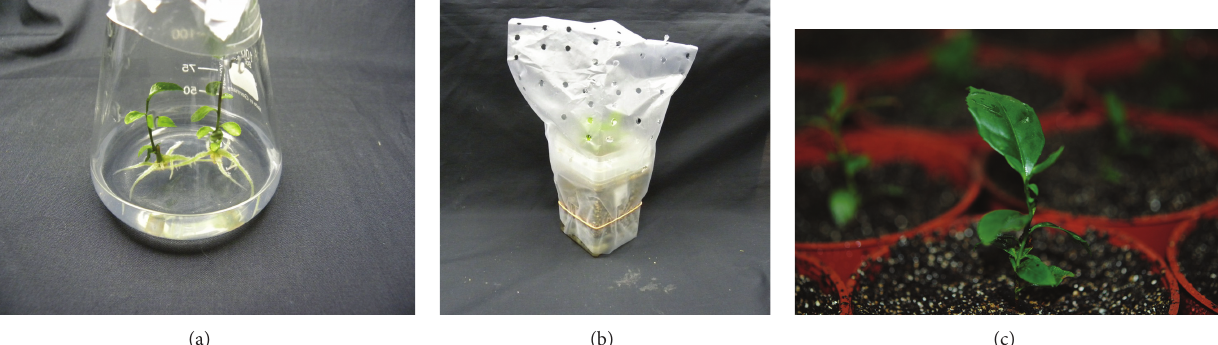
Figure 9: Rooting and acclimatization. (a) Rooted microshoots of tea after IBA treatment; (b) rooted cutting in vermiculite, covered with plastic for retention of humidity during acclimatization; (c) plants transferred to plastic pots in